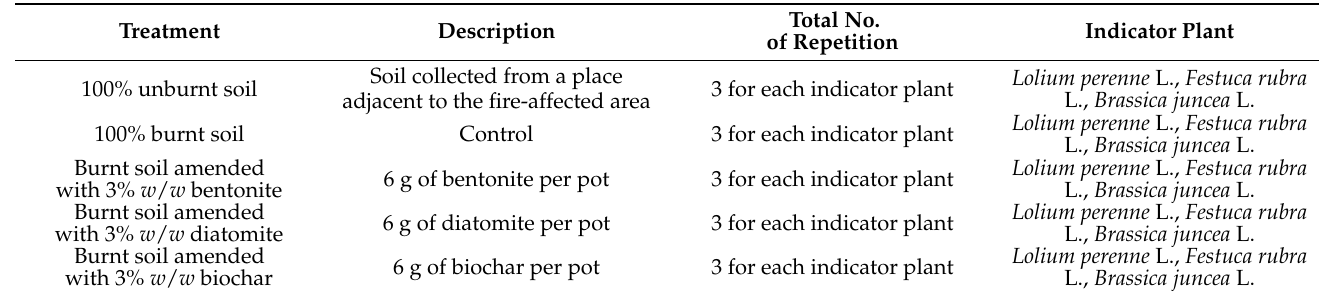
Table 2. Organization of laboratory experiment.